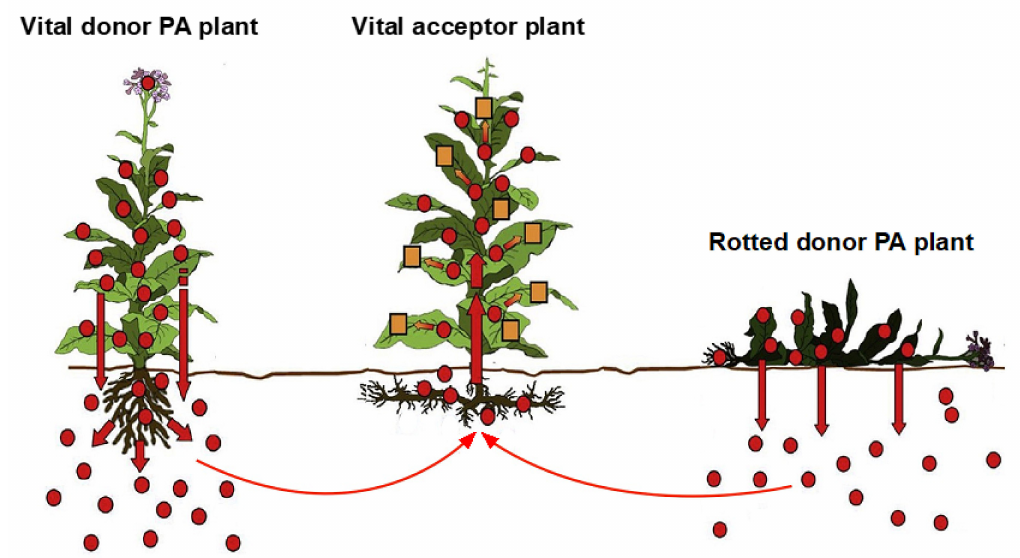
Figure 5. System of horizontal natural product transfer of pyrrolizidine alkaloids. Vital donor PA plants biosynthesize, in their leaves, PAs, which may reach the soil through various mechanisms. Including, preferentially, the rhizome and roots extruding from PAs. In addition, PAs, located in leaves of rotted or rotting donor PA plants, enter the soil. Assisted by surface water, PAs contaminating the soil arrive at the rhizome of roots of a vital acceptor plant, and, following their uptake, reach aerial parts of the plants, shown as small red dots, whereas some PAs may undergo metabolic modification, shown as small yellow squares. Abbreviation: PA, Pyrrolizidine alkaloid. This figure was modified and adapted from previous illustrations and suggestions of the group of Selmar